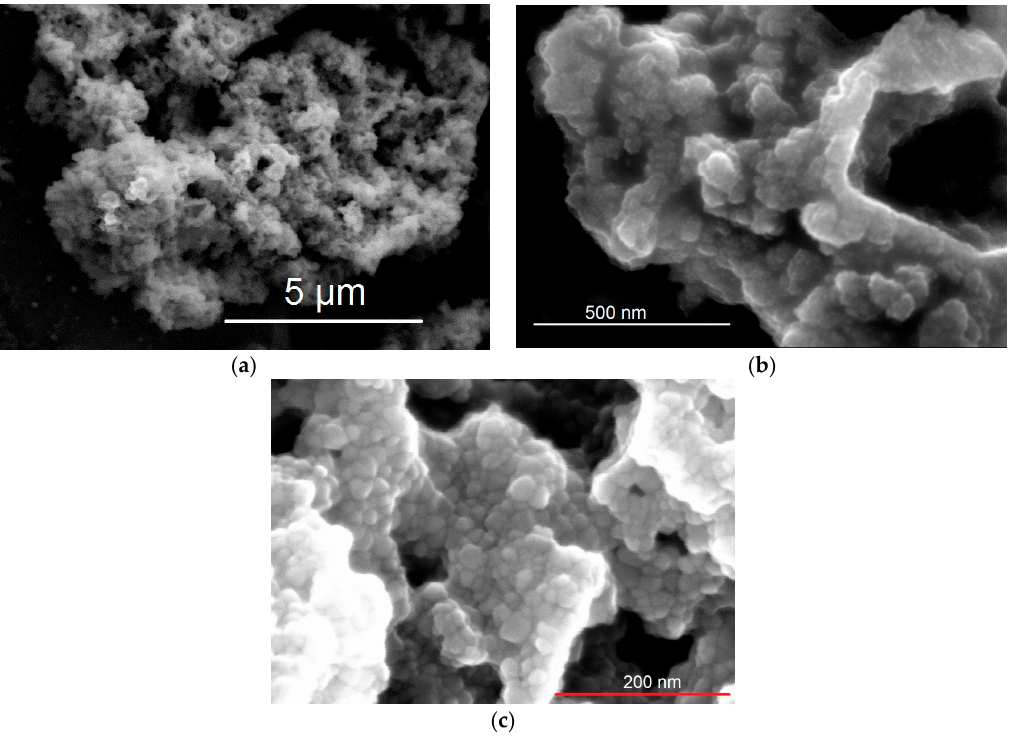
Figure 3. ( a ) Scanning electron microscopy image of the SnO 2 polymer matrix in a 10,000 fold magnification as deposited on the hotplate structure; ( b ) A 100,000 fold magnification of the same SnO 2 polymer matrix; ( c ) After burning the PVP the SnO 2 nanoparticles sinter together during the heating process and agglomerate in clusters of several 100